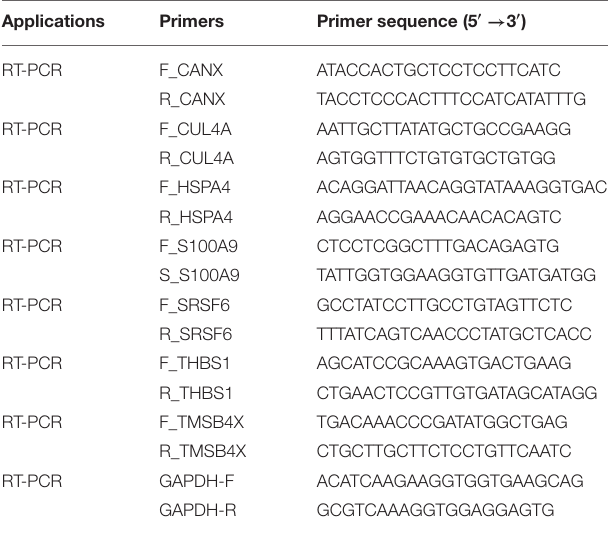
TABLE 1 | Sequences of the primers used for detection and quantification of the mRNA expression